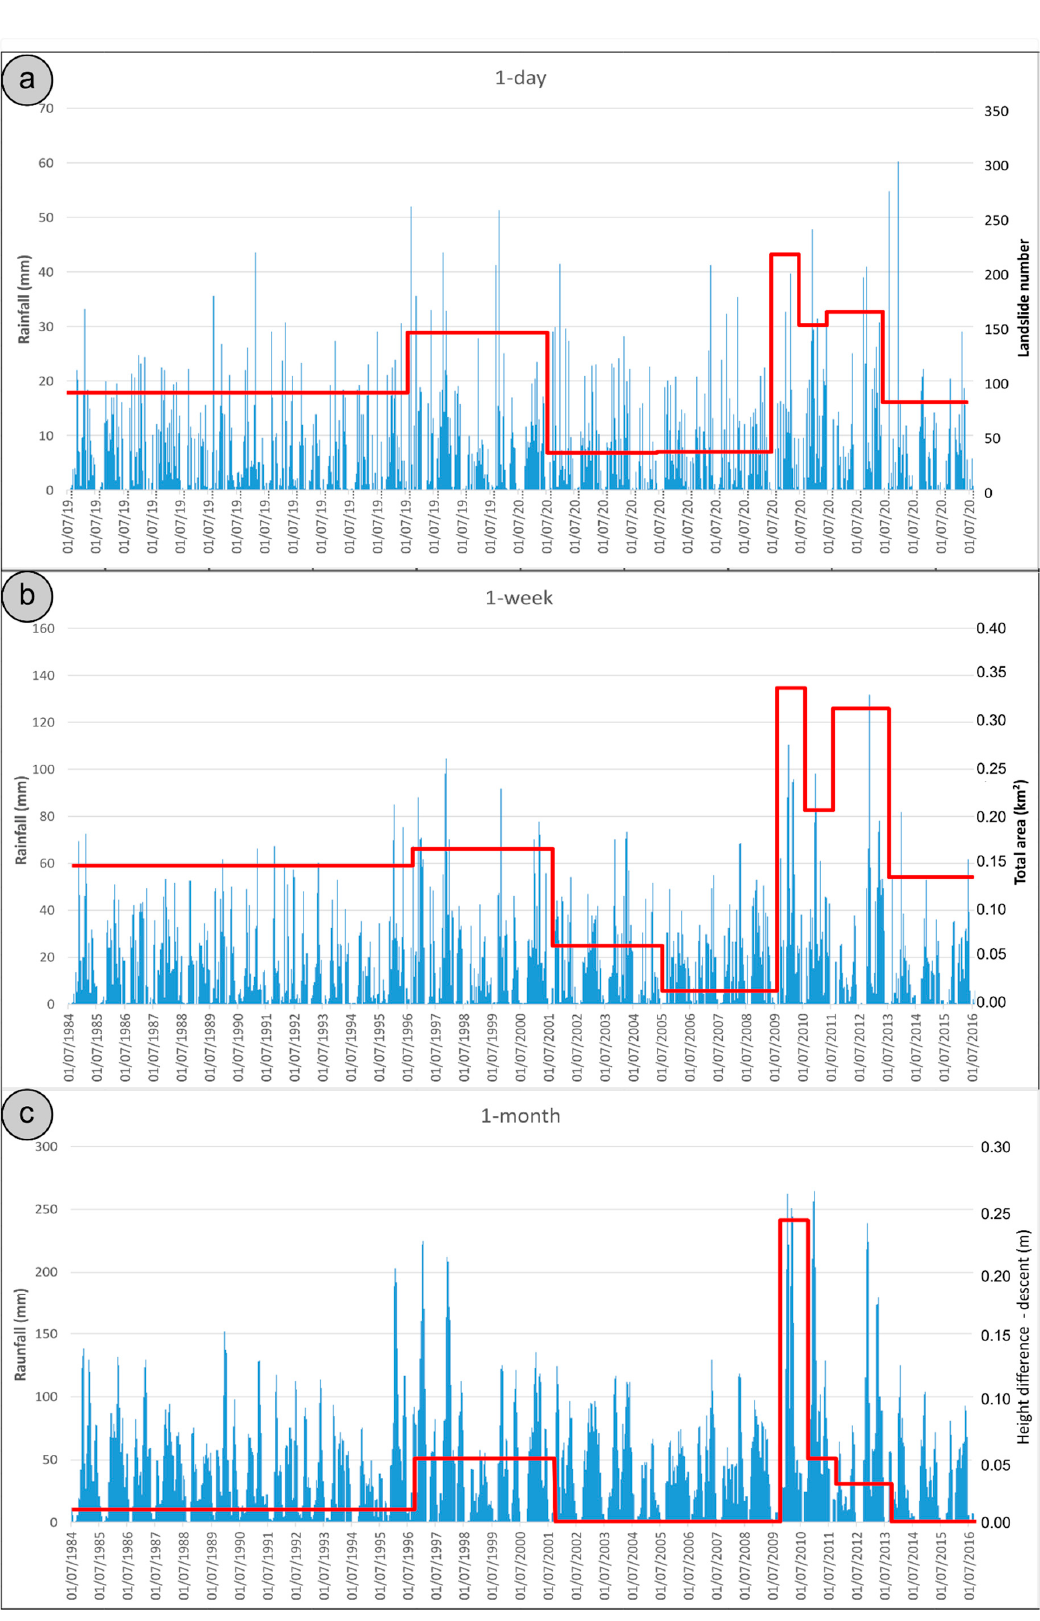
Figure 13. Relationships between landslide activity and rainfalls: ( a ) 1 ‐ day rainfalls and landslide number; ( b ) 1 ‐ week rainfalls and total area (km 2 ); ( c ) 1 ‐ month rainfalls and average height differences.